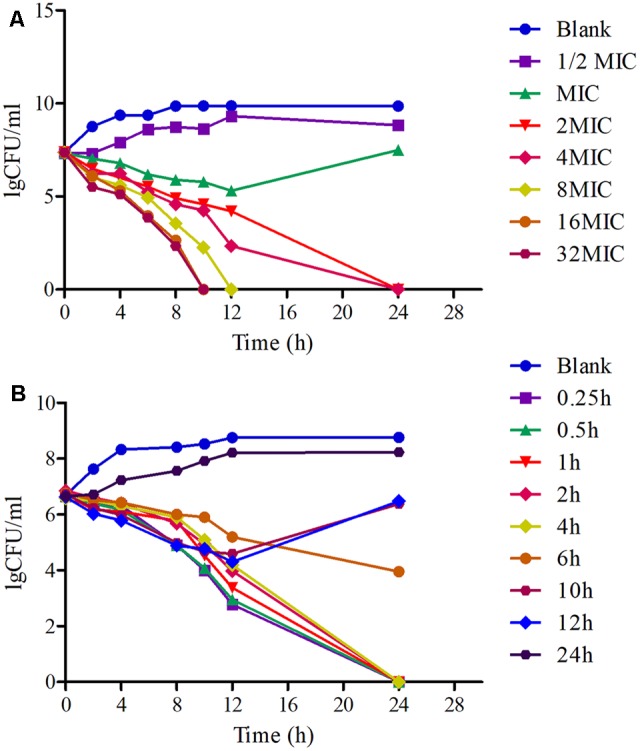
The killing-time curves of MBF against SS (HB2) in vitro (TSB) and ex vivo (Serum). (A) Representing the curve in TSB; (B) representing the curve in serum.